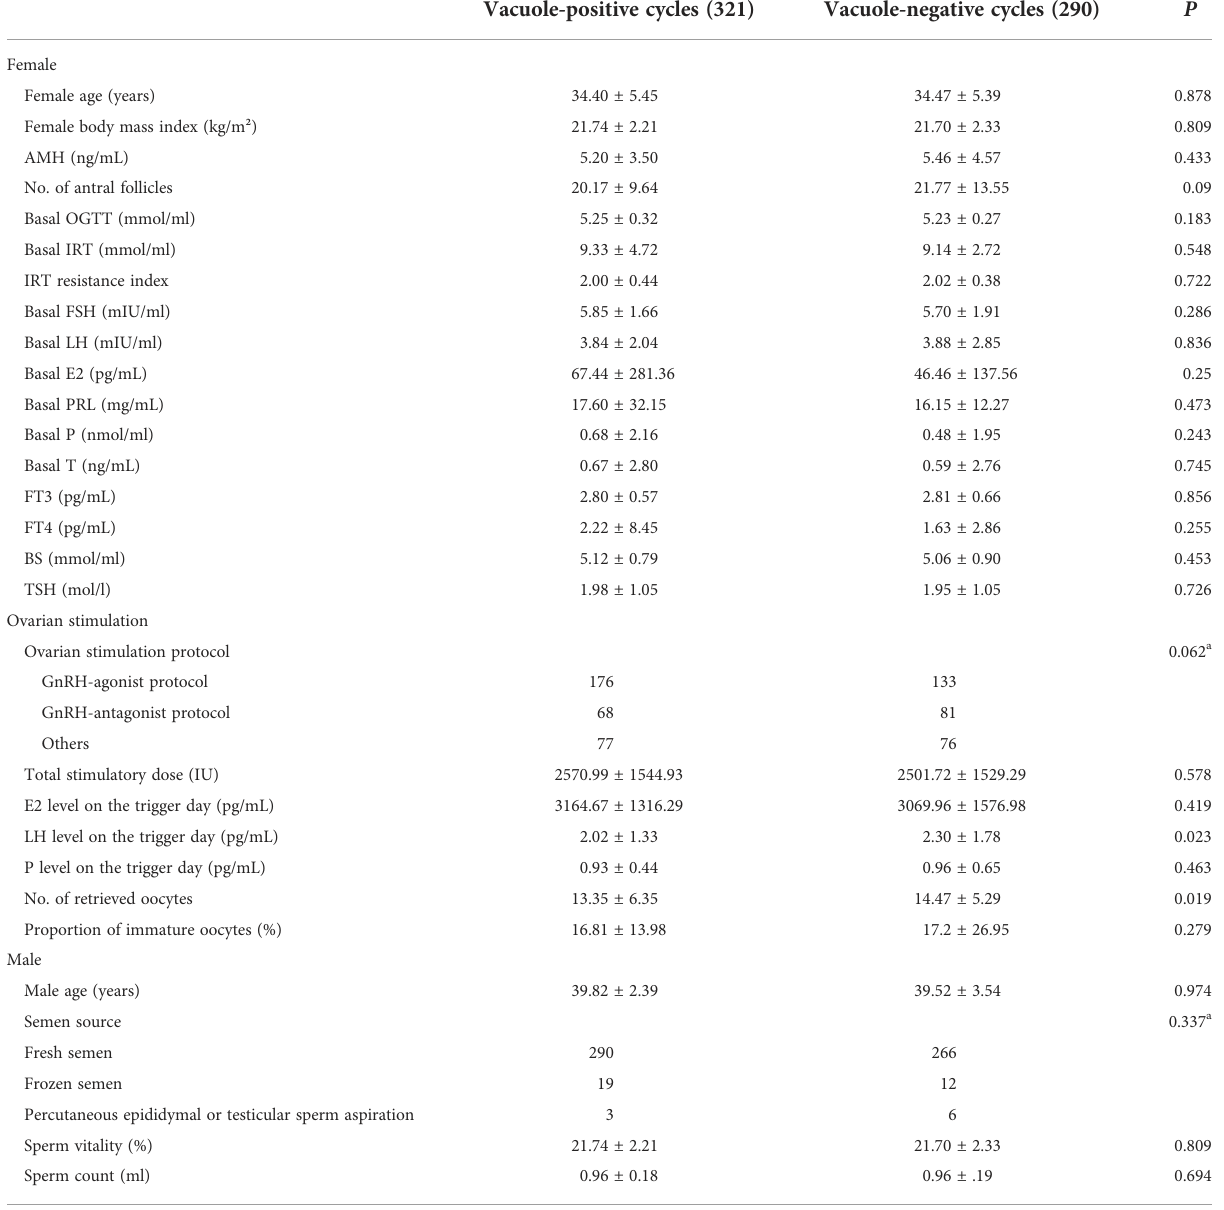
TABLE 1 Demographic and stimulation data of vacuole-positive and vacuole-negative